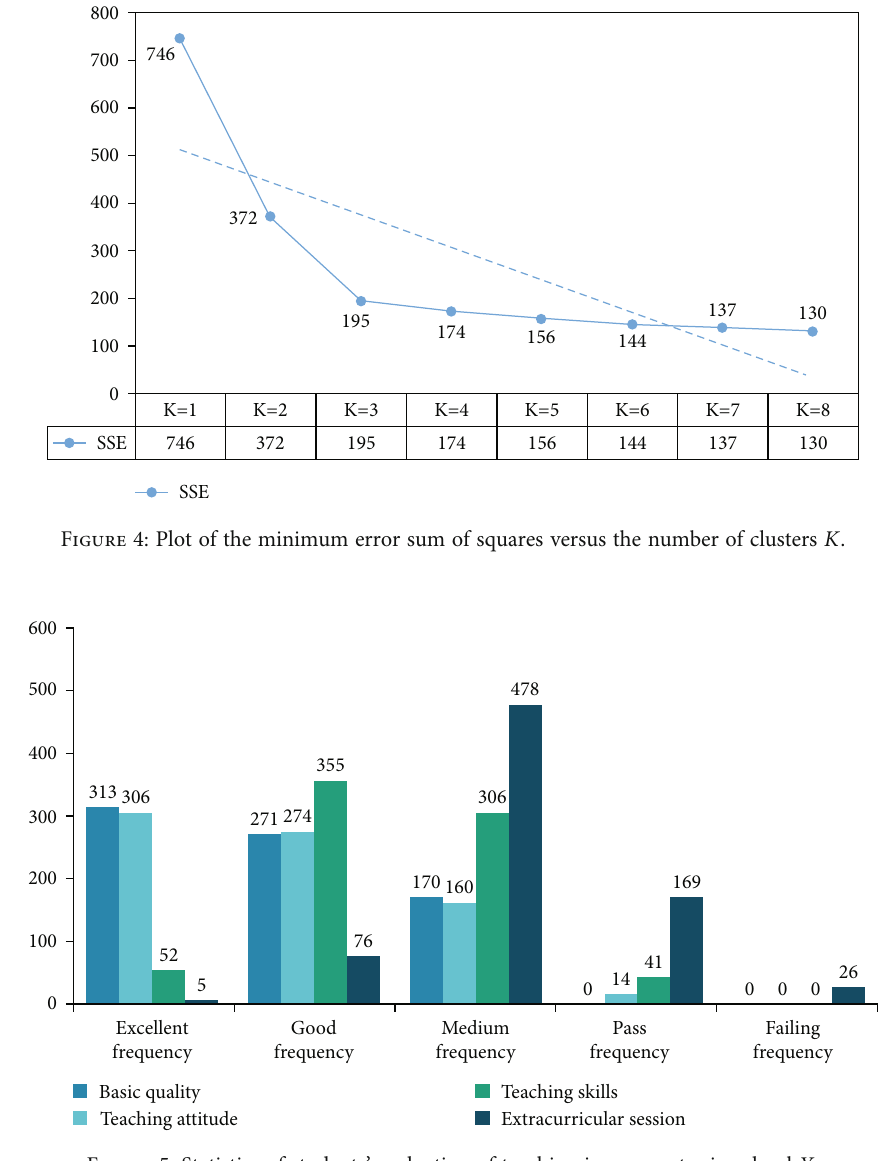
Figure 5: Statistics of students ’ evaluation of teaching in a semester in school Y